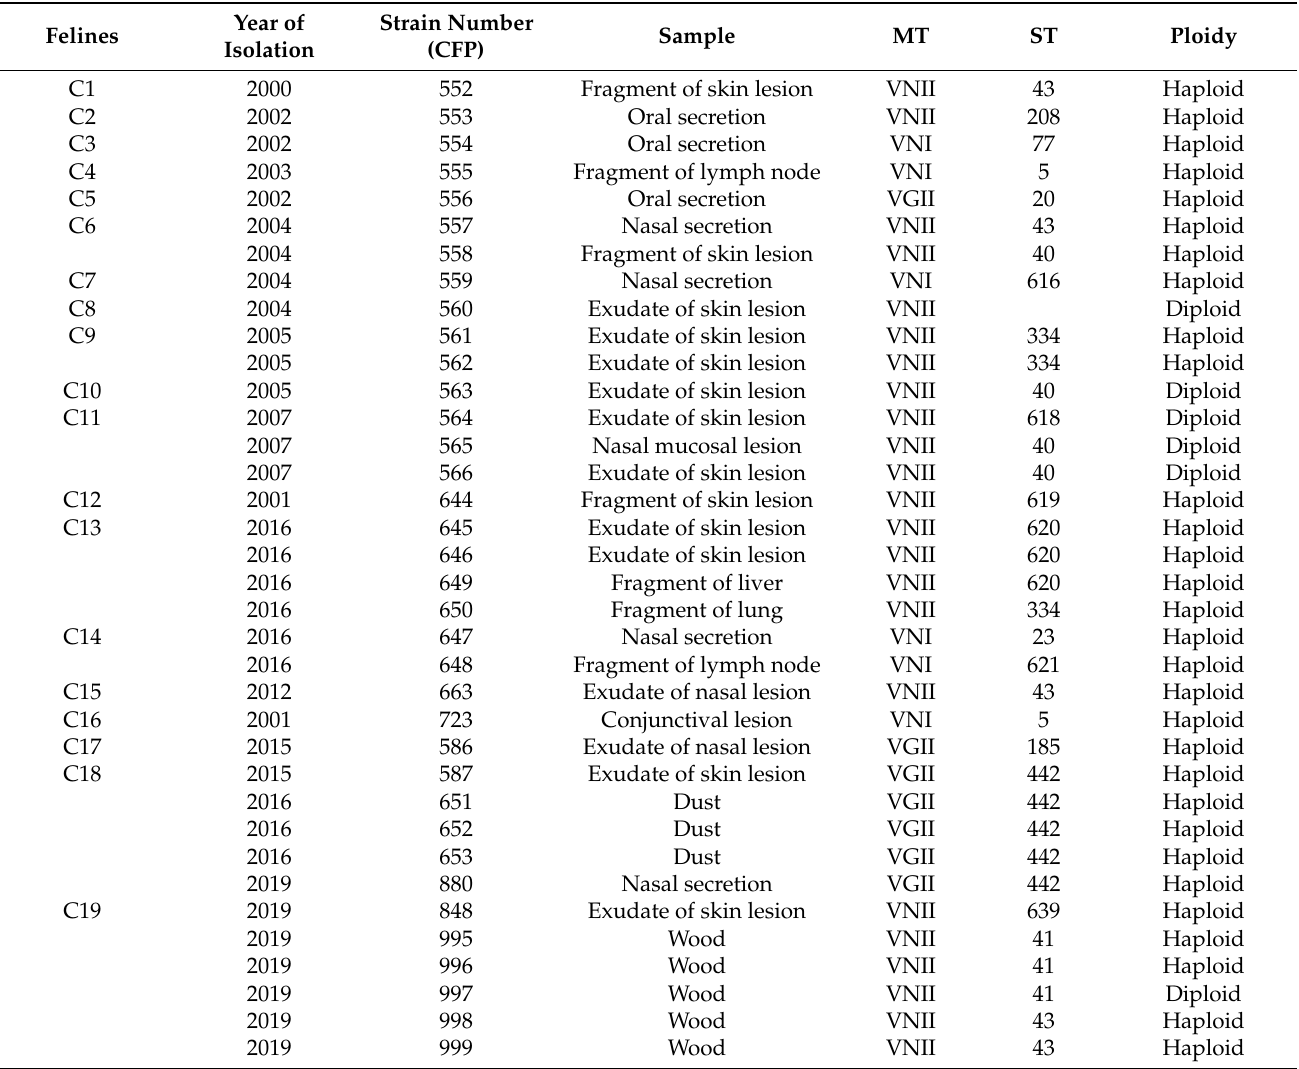
Table 1. Data of Cryptococcus spp. isolates from the cats studied according to year and anatomical sites of isolation, molecular type, and